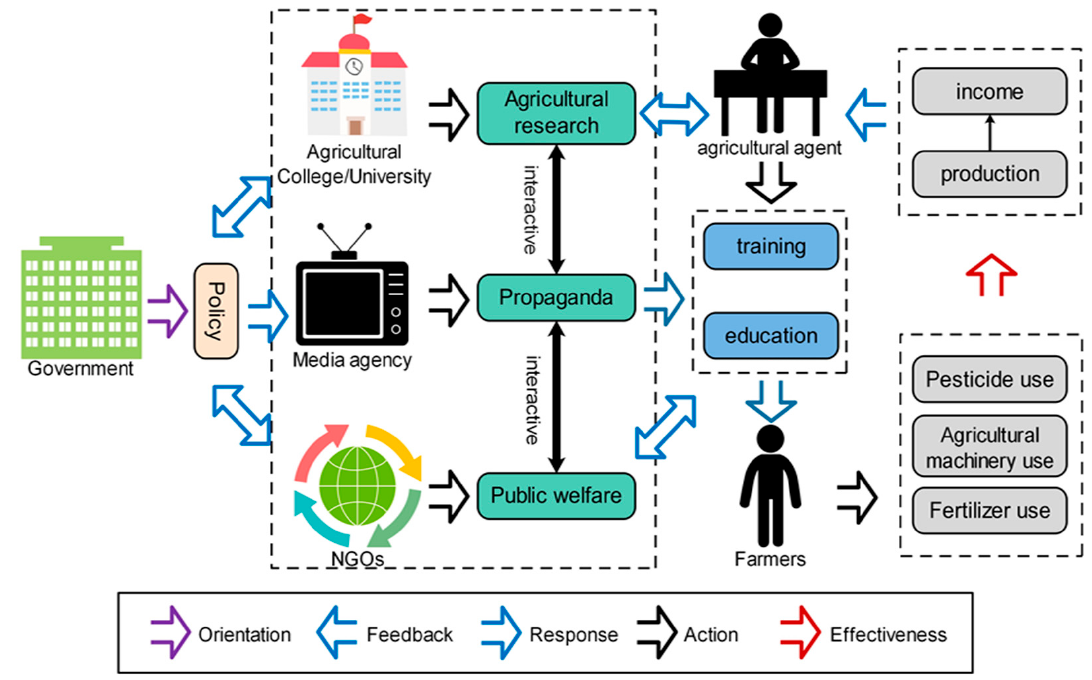
Figure 7. Possible agricultural enforcement measures.